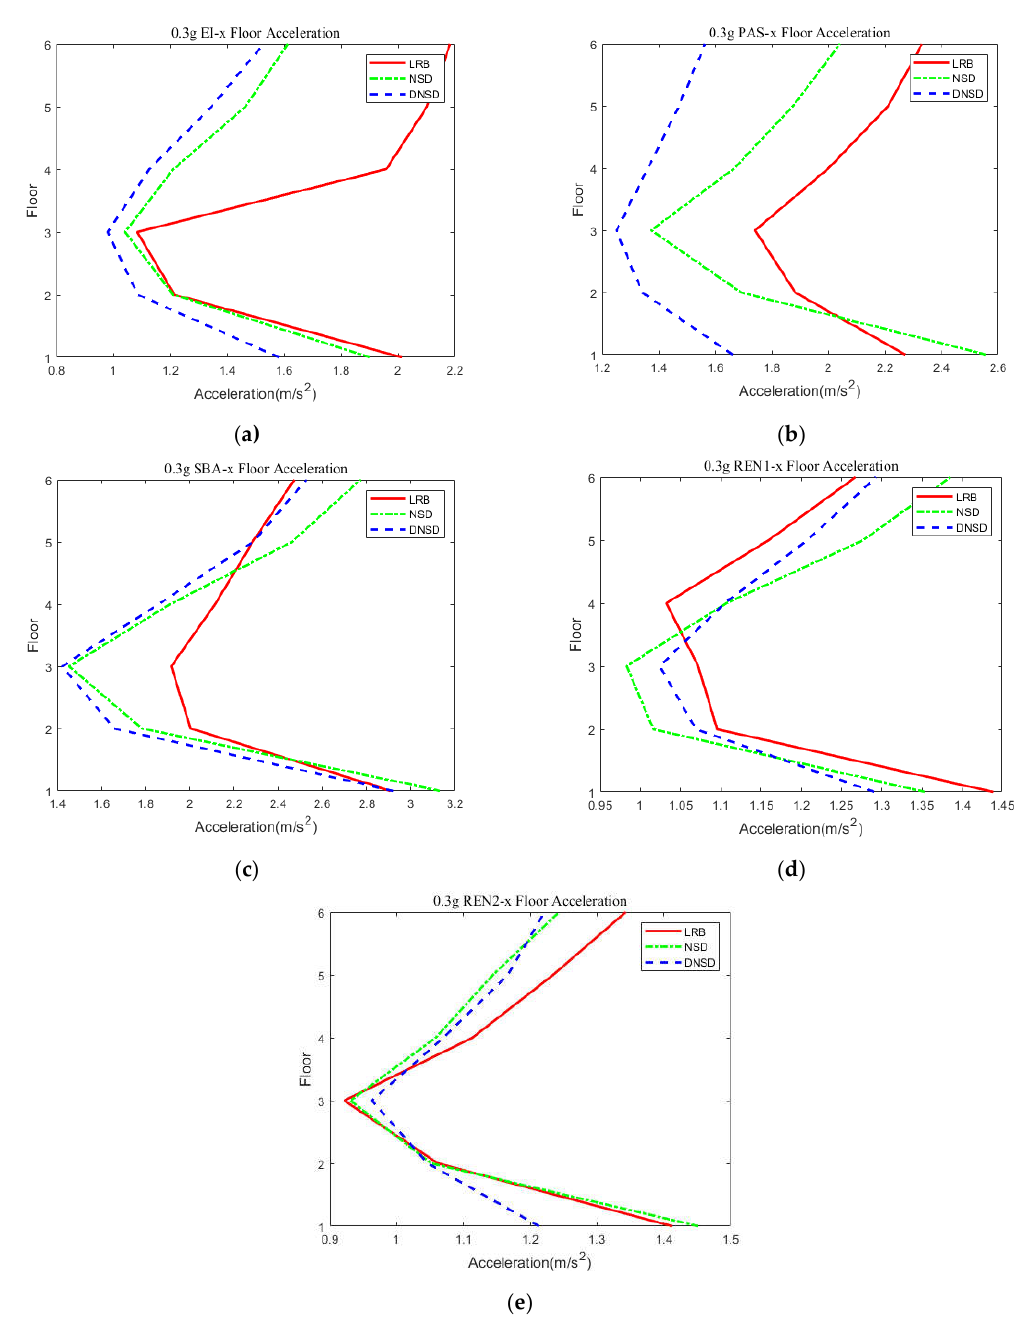
Figure 23. Comparison of floor accelerations among three models under different earthquake waves at a peak of 0.3 g. ( a ) Floor acceleration at 0.3 g peak of El wave ( b ) Floor acceleration at 0.3 g peak of PAS wave. ( c ) Floor acceleration at 0.3 g peak of SBA wave. ( d ) Floor acceleration at 0.3 g peak of REN1 wave. ( e ) Floor acceleration at 0.3 g peak of REN2 wave.